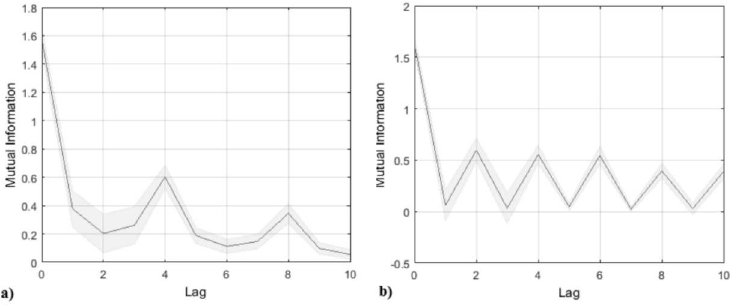
Figure 3. Mutual information for the EHG signal: a) the raw, b) the